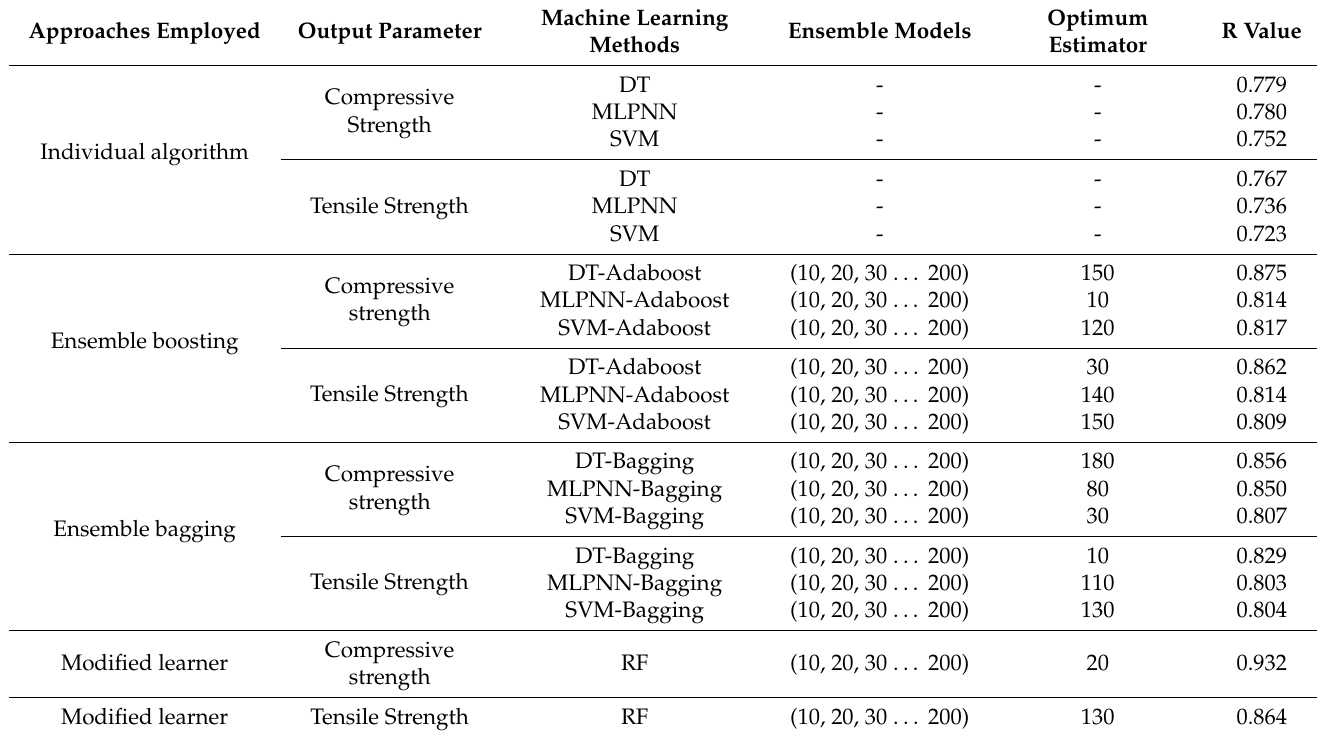
Table 7. R 2 values of models.